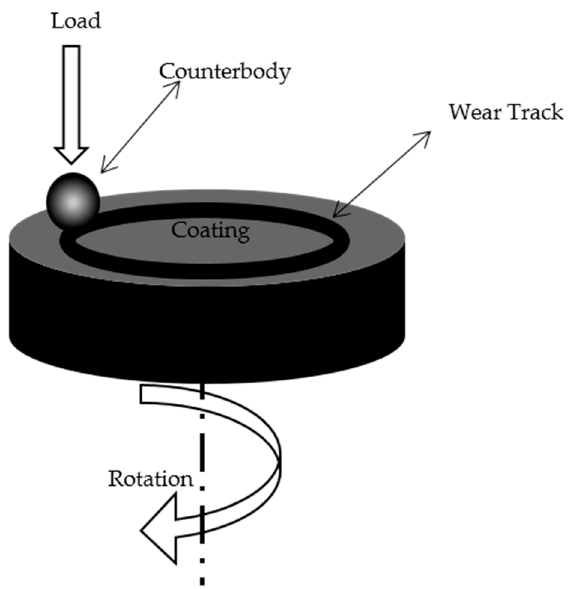
Figure 2. Schematic illustration of ball-on-disk tribotester.